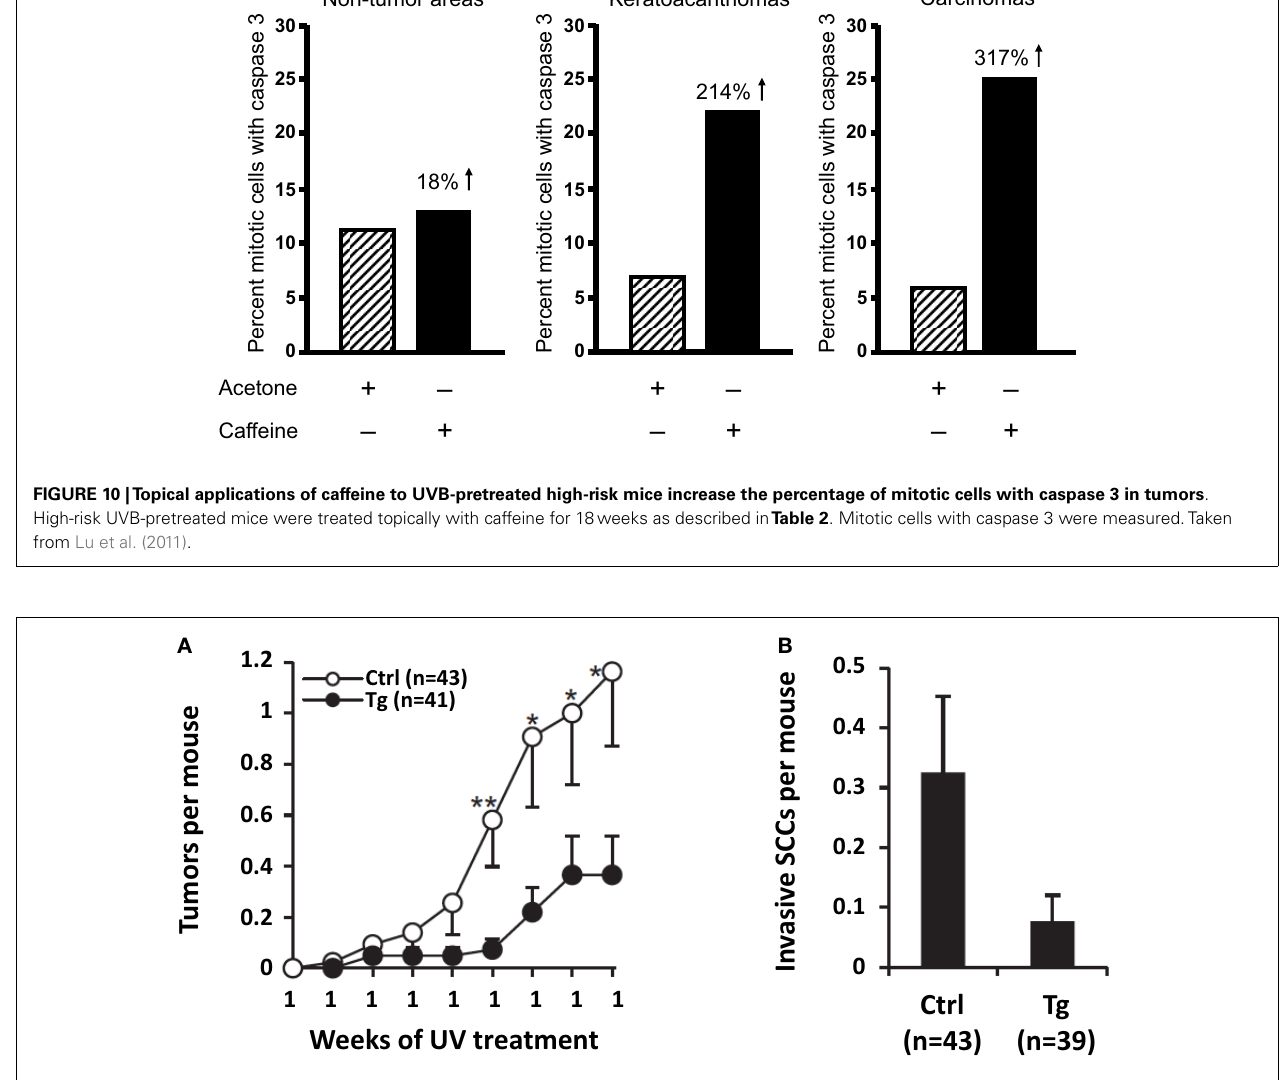
FIGURE 11 | Effect of genetic inhibition ofATR on UVB-induced carcinogenesis .Transgenic mice with decreased ATR function in the skin were crossed into a UV-sensitive Xpc − / − background.These transgenic mice (Tg) and their transgenic-negative littermate controls with functional ATR (Ctrl) were treated with UVB for 23weeks. In (A) , it is shown that ATR-kd transgene suppresses UV-induced tumor development. Mean number of tumors per mouse is shown up to 19week, the point when some mice with advanced tumors were killed and the cohort was no longer complete (Error